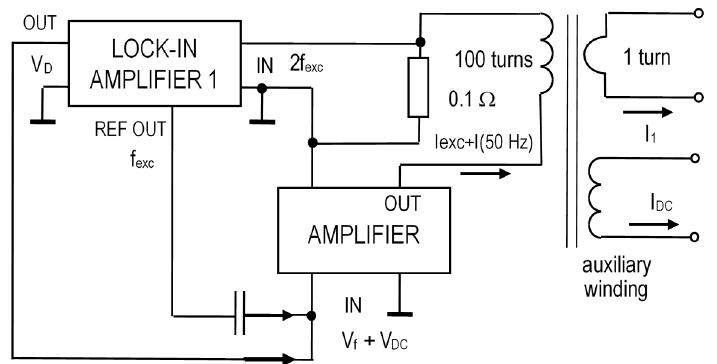
Figure 5. DC-compensated current transformer.